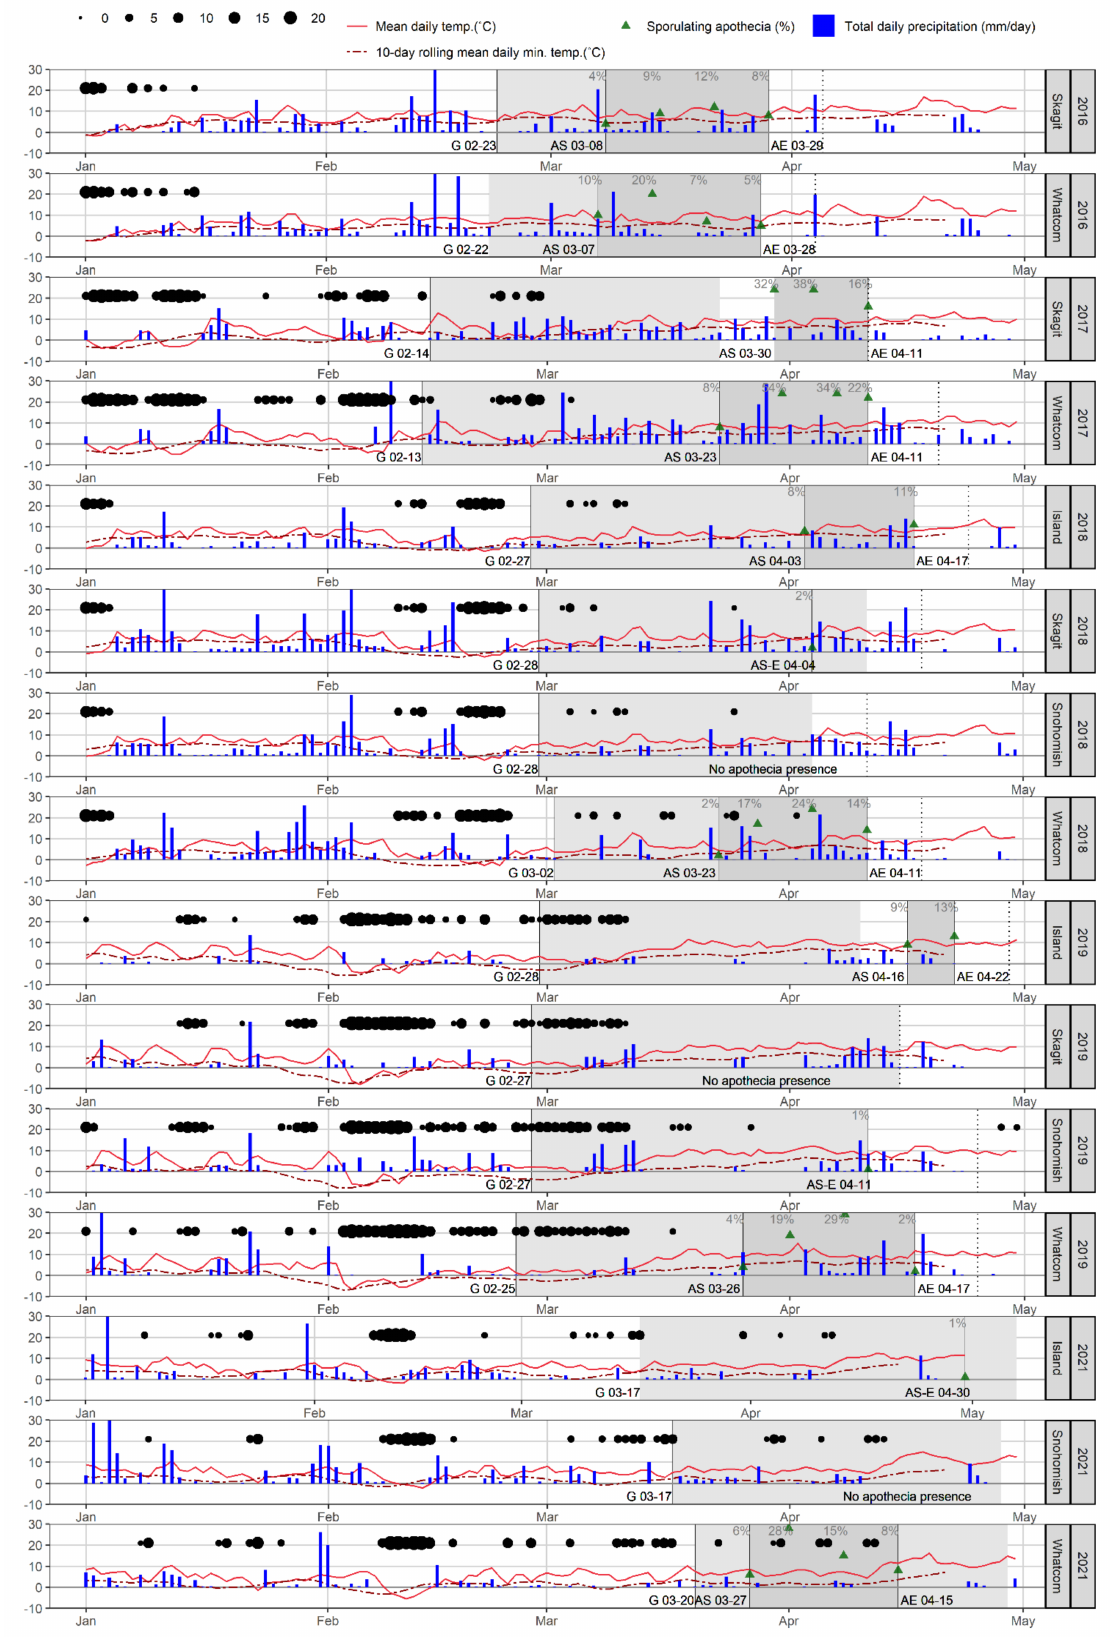
Figure 3. Daily weather and Monilinia vaccinii-corymbosi apothecial development records for the period 2016 to 2019 and 2021, at four sites (Island, Skagit, Snohomish, Whatcom (not present in